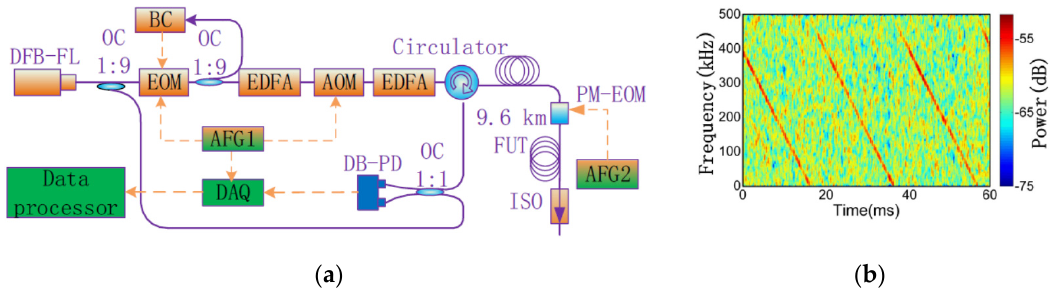
Figure 11. ( a ) Experimental setup and ( b ) results with a chirped vibration. Reproduced with permission from our previous paper [19], published by Optical Society of America, 2015.